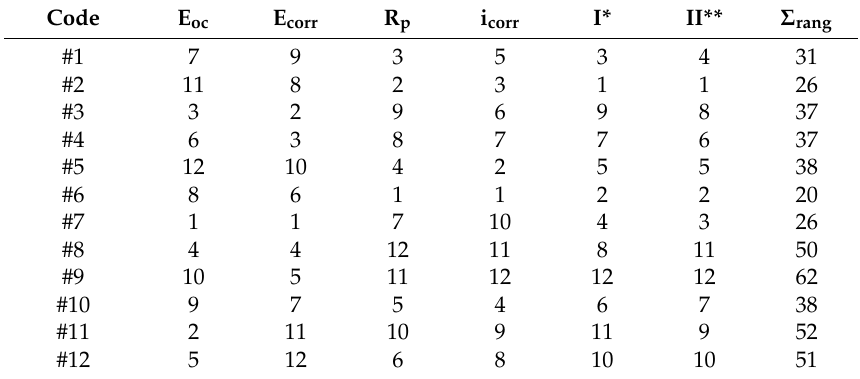
Table 5. Ranks attributed to 12 steels according to 6 parameters of generalized corrosion Code